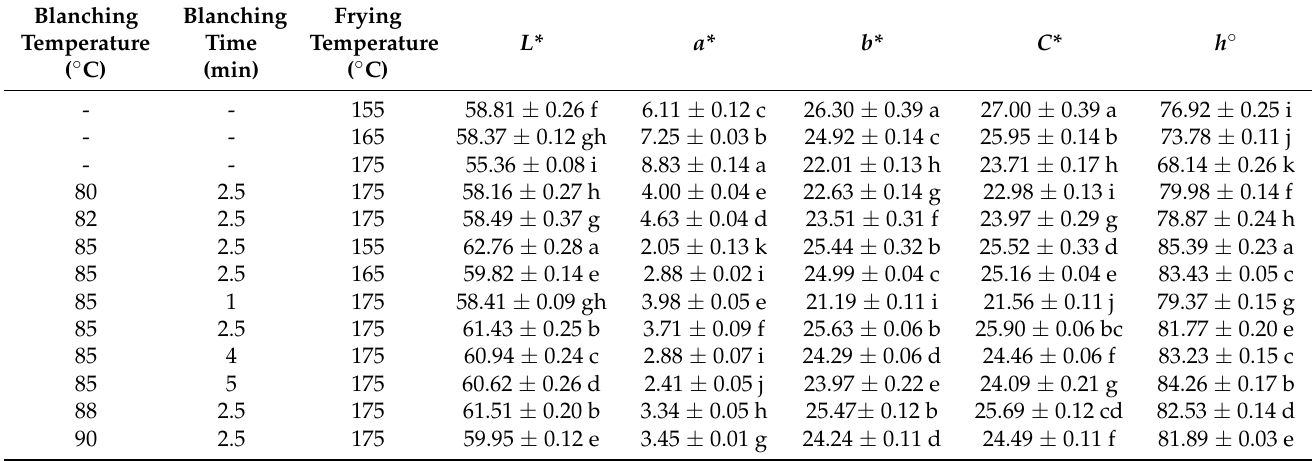
Table 3. Color parameters of potato crisps ( cv. Ismena), depending on technological parameters.